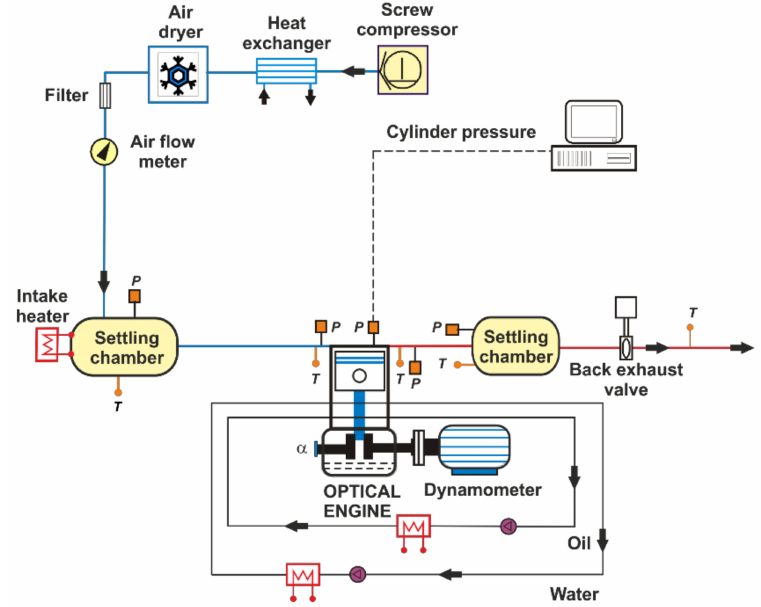
Figure 1. Test cell